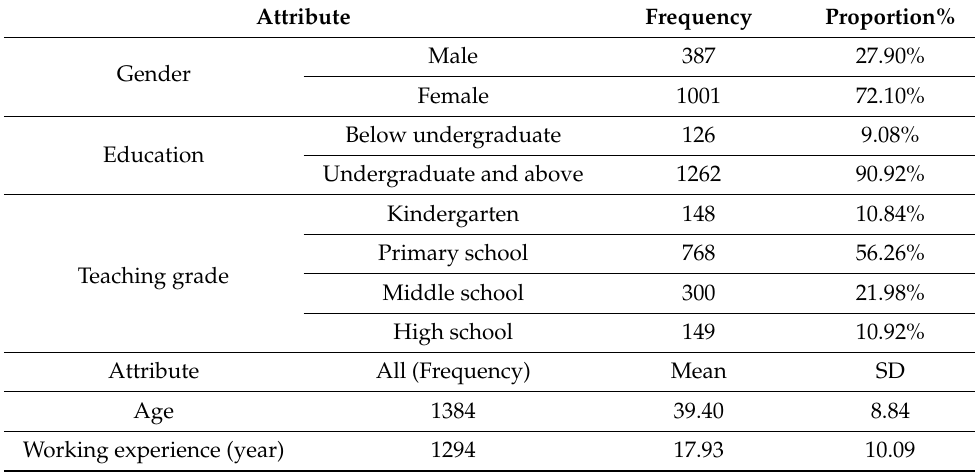
Table 1. Demographic characteristics of participants. Attribute Frequency Proportion% Gender